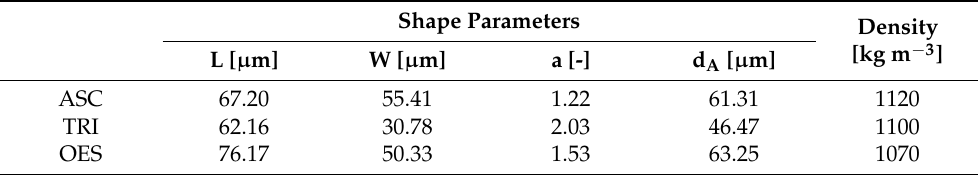
Table 2. Geometry parameters and densities of helminth eggs